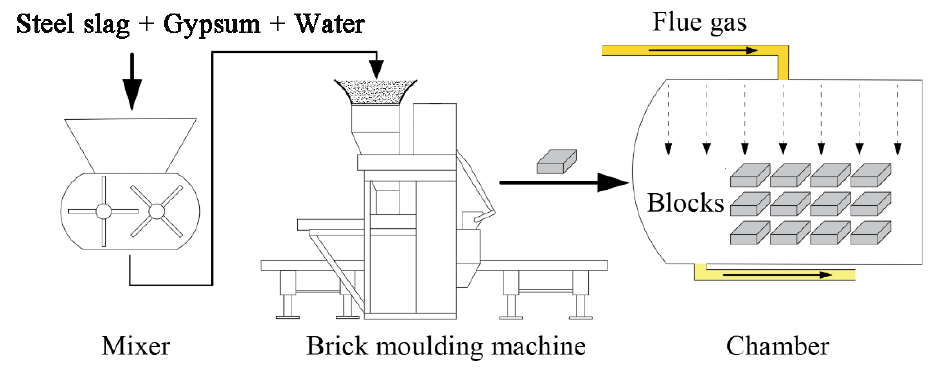
Figure 1. Press-shaping methods and subsequent carbonation curing of steel